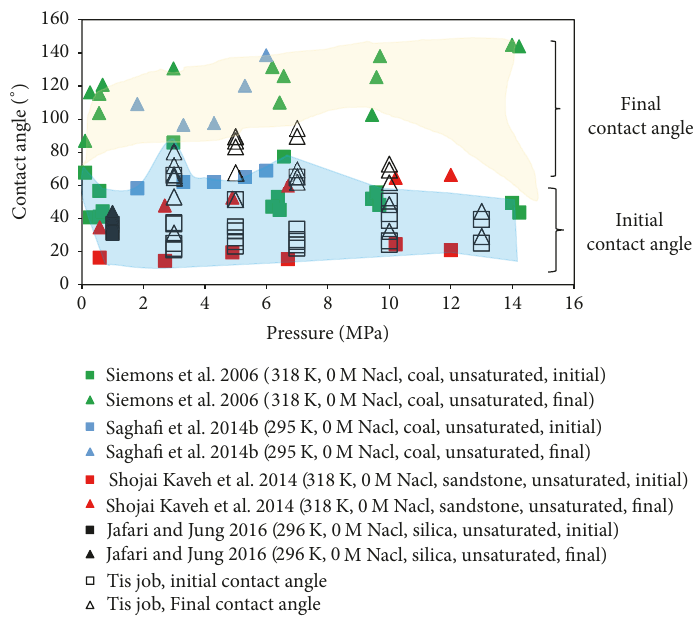
Figure 8: Comparison of contact angles on mica substrate in this study to those in previous studies using coal, rock silica, and mica substrates under unsaturated condition.